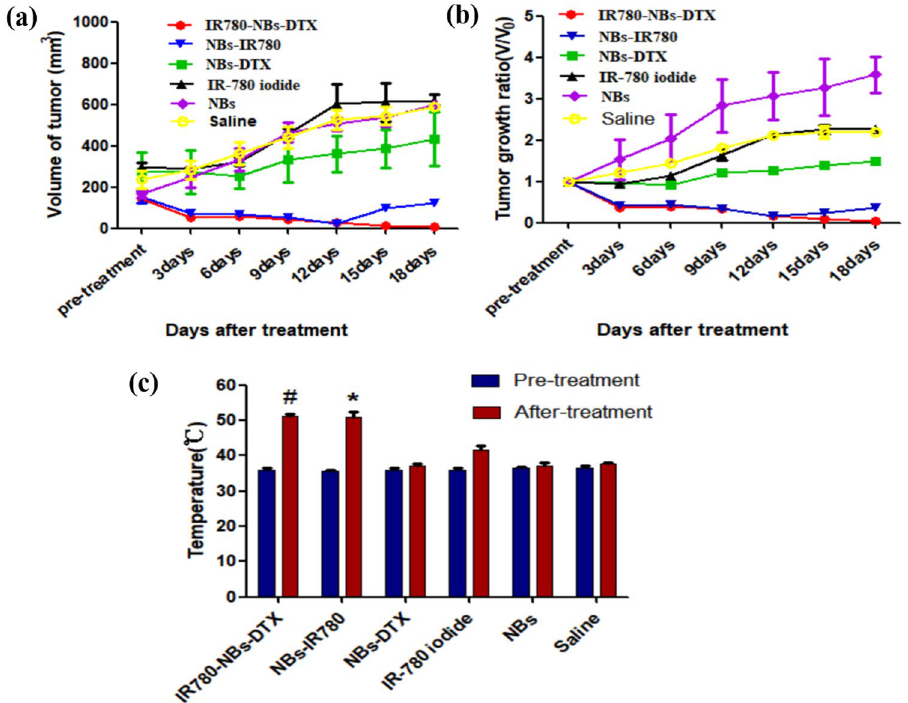
Figure 14. Statistical analysis of the changes in the volume and local temperature of pancreatic cancer xenografts in different groups before and after combined treatment. ( a ) The trend of tumor volume over time in different groups. ( b ) The trend of the tumor growth ratio (v/v0) over time in different groups. ( c ) The temperature change of pancreatic cancer in different groups before and after combined treatment. # P < 0.05, significantly different from the temperature before combined treatment; *P < 0.05, significantly different from the temperature before combined treatment.